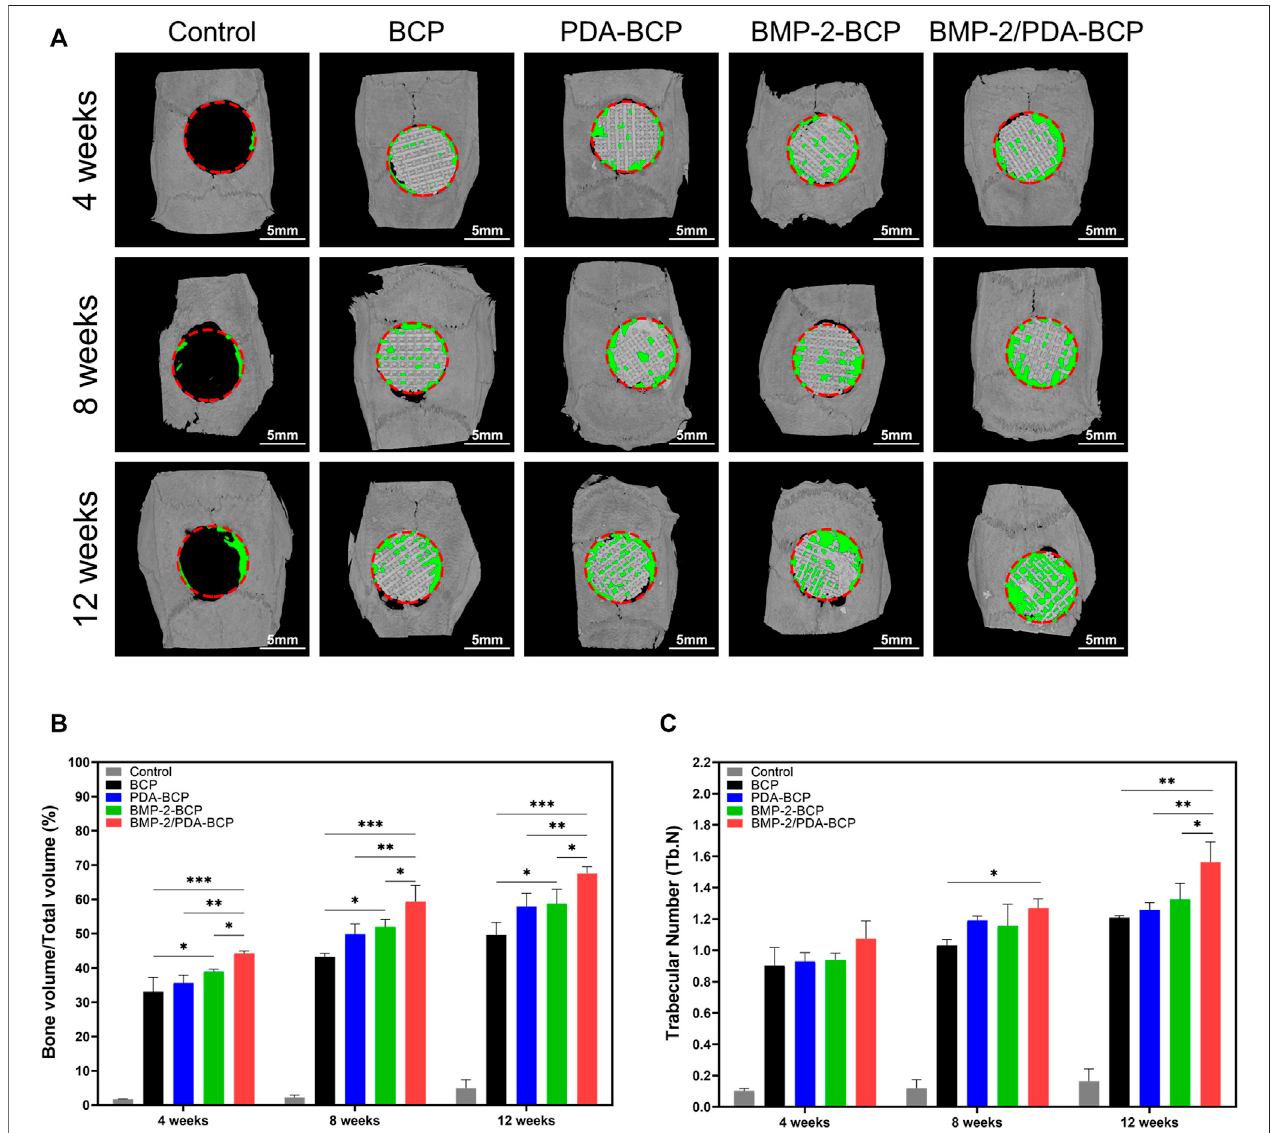
FIGURE 7 | Micro-CT analysis of the effects of various scaffolds on new bone formation in the critical-size bone defect model of SD rats. (A) Three-dimensional reconstruction of micro-CT images of the various scaffolds implanted in the rat calvarium at 4, 8, and 12 weeks. Scale bars = 5 mm. (B) Regenerated bone volumes on the various scaffolds were quanti fi ed as bone volume divided by total volume (BV/TV). * p < 0.05, ** p < 0.01, and *** p < 0.001. (C) The number of bone trabeculae were analyzed by software. * p < 0.05, *** p < 0.001.